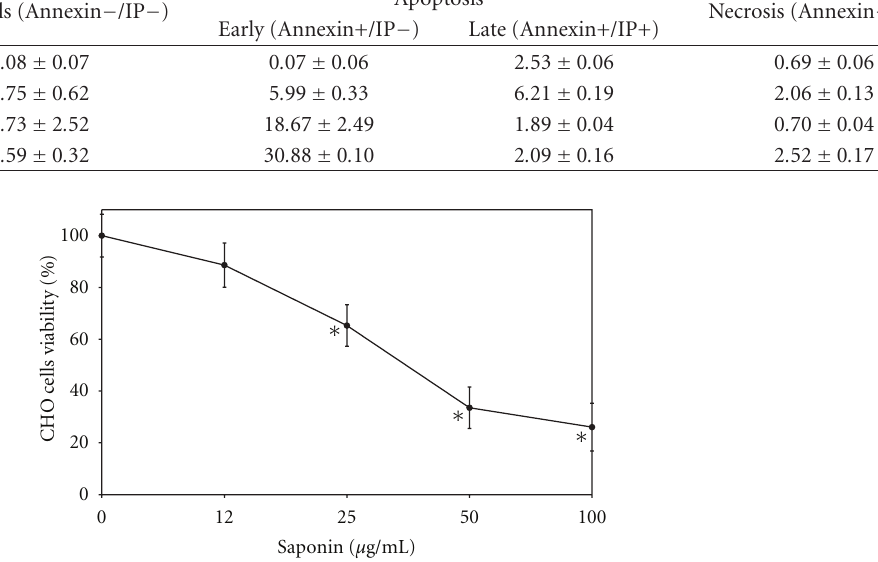
Figure 1: Percentage of the viability of CHO-K1 cells following treatment with saponin measured by the MTT assay; mean of three experiments ± SD. ∗ P < 0 . 005.